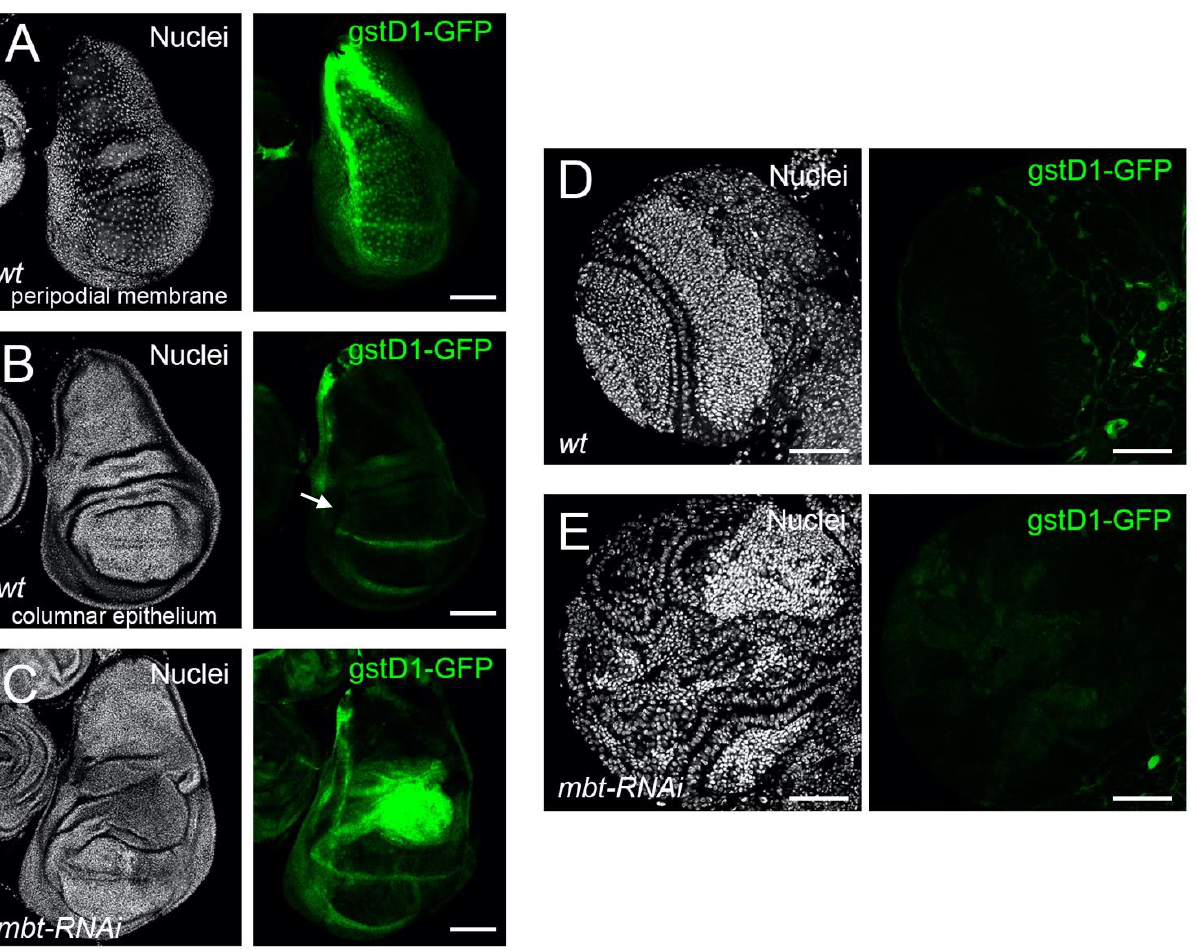
Figure 3. Oxidative stress detected with gstD1-GFP reporter in mbt-RNAi mutant wing imaginal discs and brain lobes. ( A – C ) Wing imaginal discs and ( D , E ) brain lobes stained with DAPI (nuclei in gray) and expressing the ROS reporter gstD1-GFP (green). ( A ) Wing discs from wild-type larvae focusing on the peripodial membrane. ( B ) Same disc showing the columnar epithelium; the arrow points to the DV boundary. ( C ) Wing disc from mbt-RNAi mutant larvae, with strong gstD1-GFP signal in the hinge region. Brain lobes from wild-type ( D ) and mbt-RNAi larvae ( E ) showing similar background levels of gstD1-GFP signal (green). Scale bars: 50 µm.